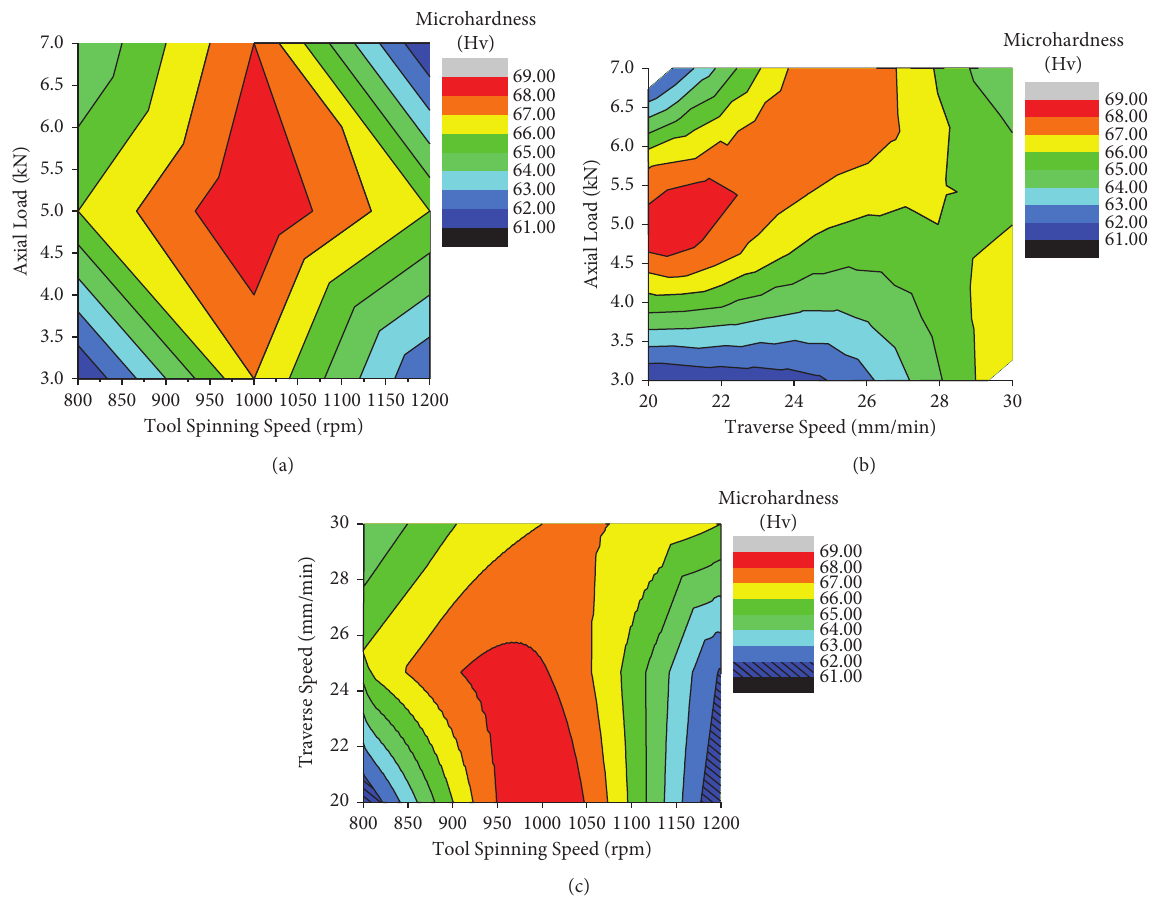
Figure 8: Contour plots of microhardness for (a) tool spinning speed versus axial load, (b) traverse speed versus axial load, and (c) tool spinning speed versus traverse speed.